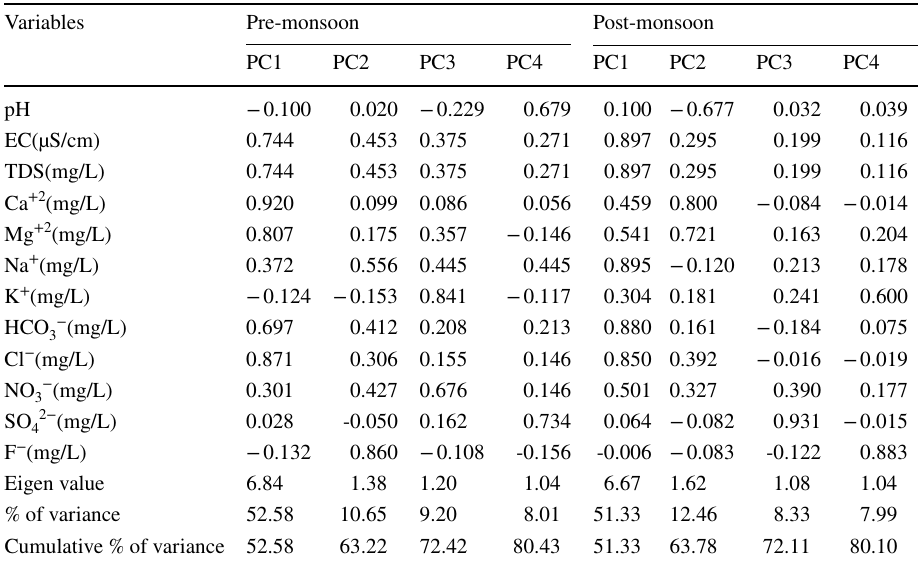
Fig. 13 Principal component plots in rotated space water samples in the pre and post- monsoon